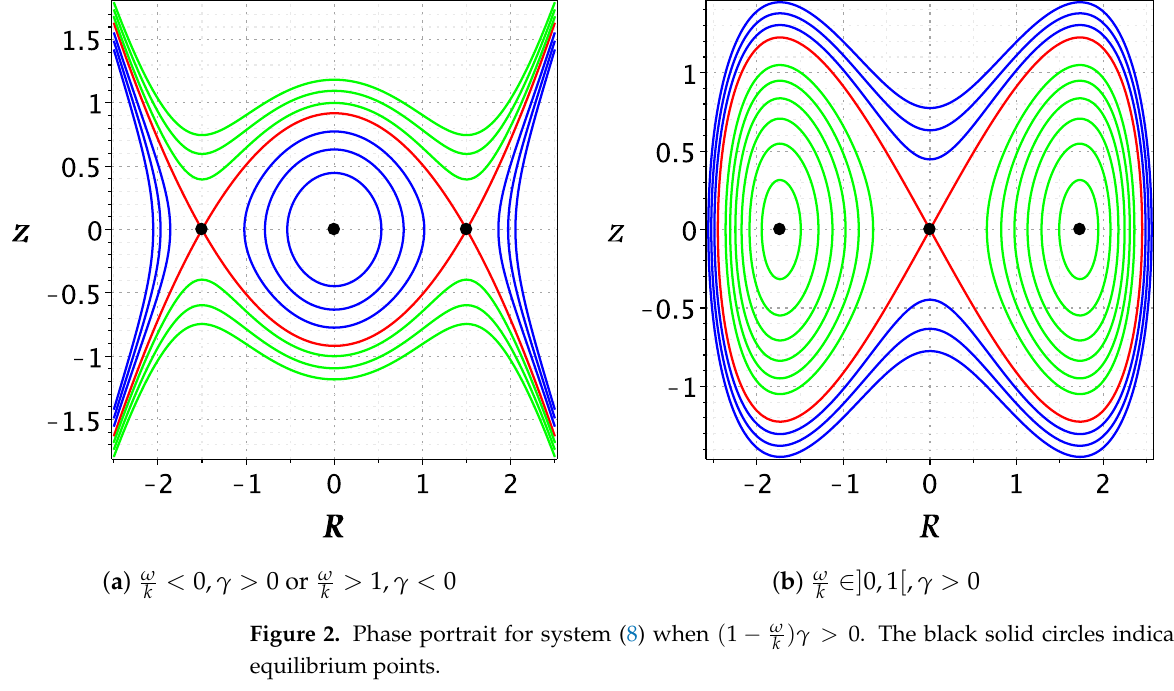
Figure 2. Phase portrait for system (8) when ( 1 − ω equilibrium